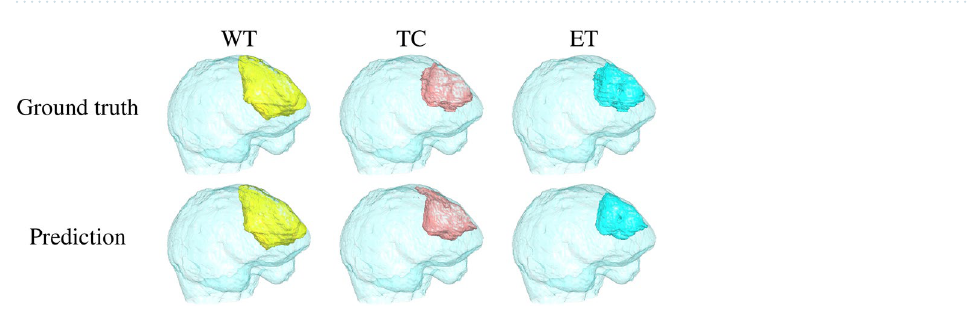
Figure 7. The Dice scores of the WT, TC, and ET in the training and testing sets vs. the number of augmentations.